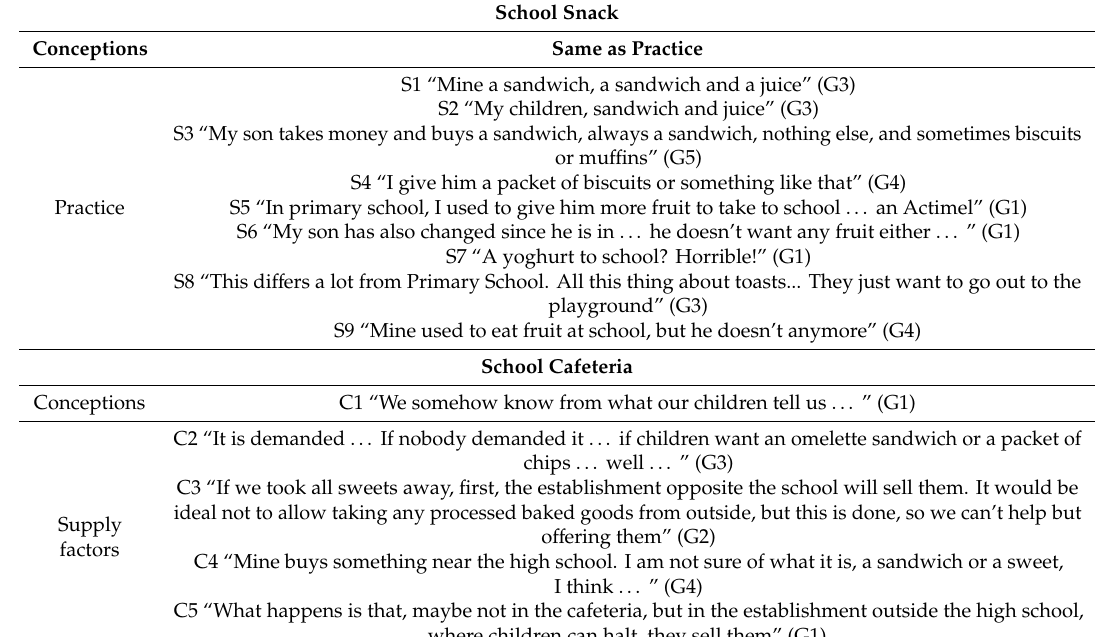
Table 4. Study categories: Schools snack and cafeteria.